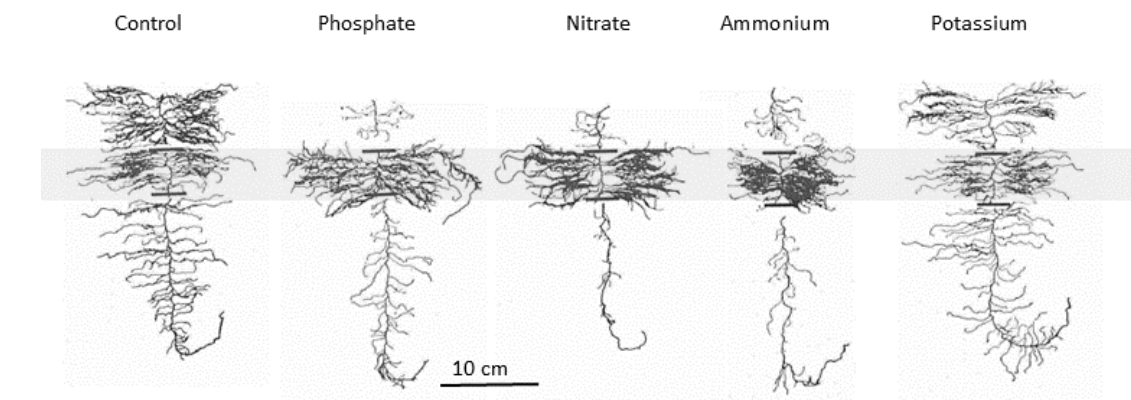
Figure 2. Effect of a localized supply of phosphate, nitrate, ammonium, and potassium on root form. Control plants received the complete nutrient solution to all parts of the root system. The other roots received the complete nutrient solution only in the middle zone (shaded), the top and bottom being supplied with a solution deficient in the specified nutrient. Adapted and reproduced with permission from Drew (1975) © John Wiley and